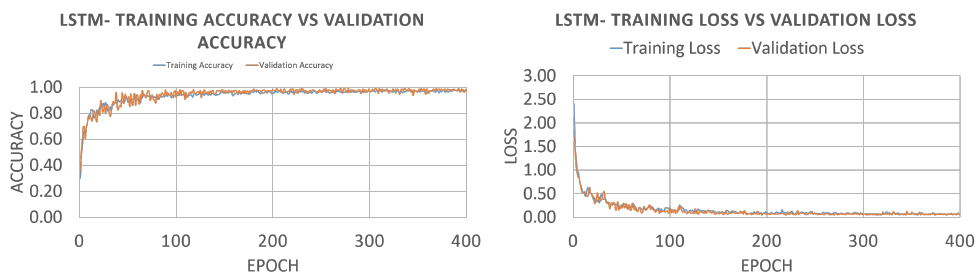
Figure 20. Comparison between the loss and accuracy for the LSTM algorithm in both training and validation